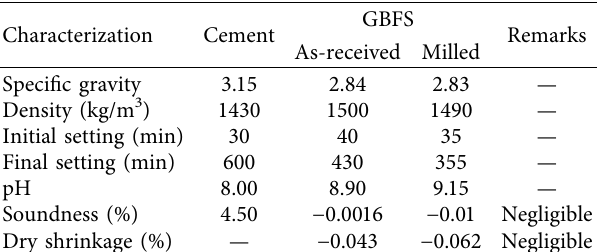
Figure 4: AutoCAD 2D plan for single dwelling unit. Table 2: Physical characterization of